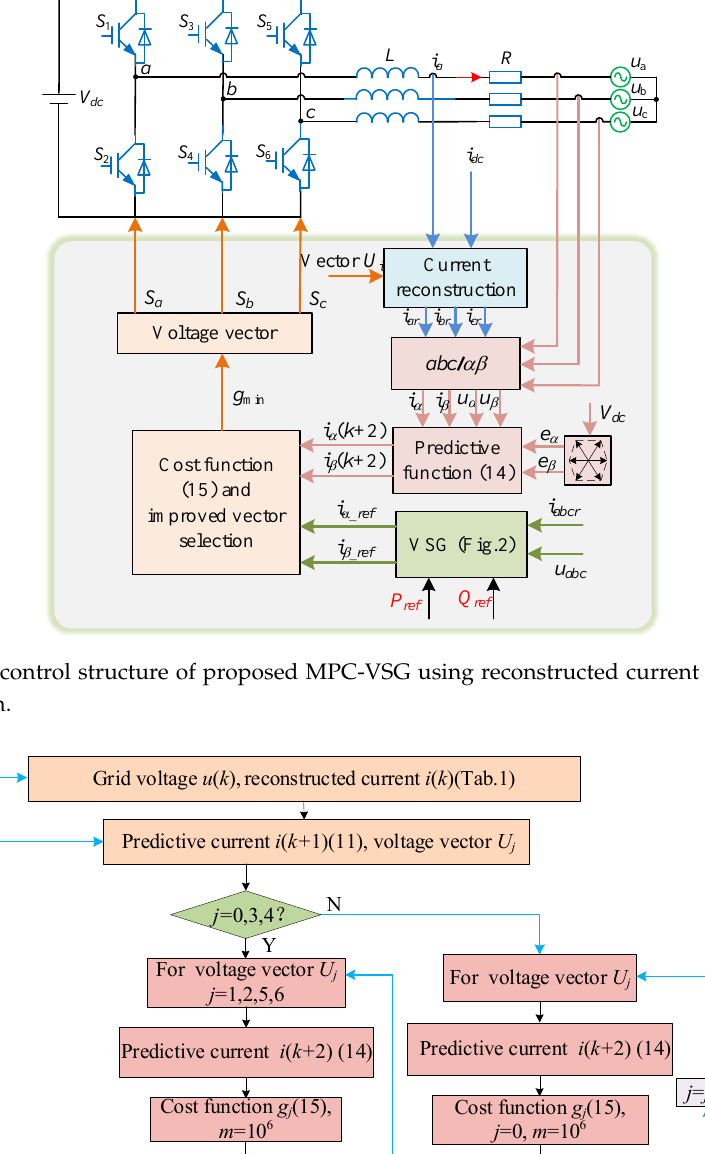
Figure 10. Experimental setup for a three-phase converter. Table 2. Experimental parameters. Parameter